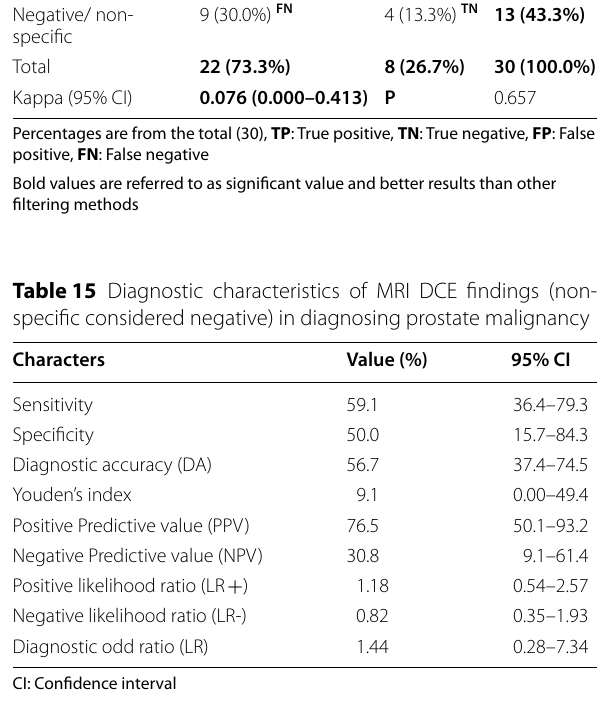
CI: Confidence interval